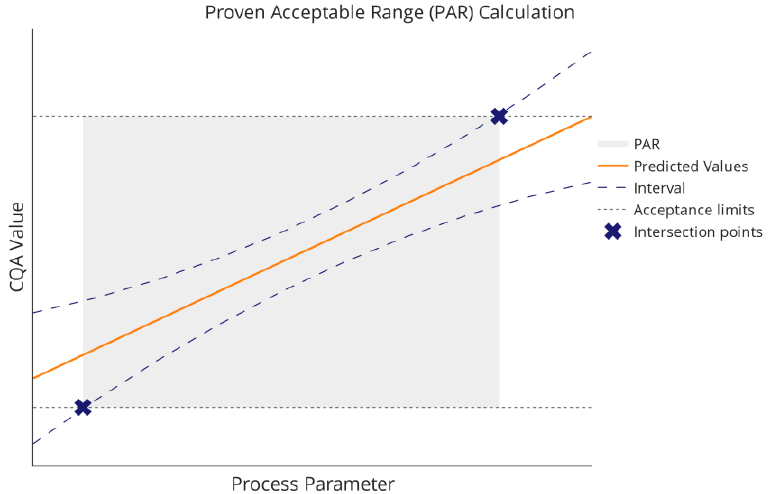
Figure 1. An example for how the PAR of a process parameter can be calculated. The predicted mean of the CQA as a function of the PP is shown in orange and the statistical interval around these predictions is illustrated as dashed lines. Lower and upper PAR boundaries can be defined by the intersection points of a statistical interval and the CQA acceptance criteria, marked as x.